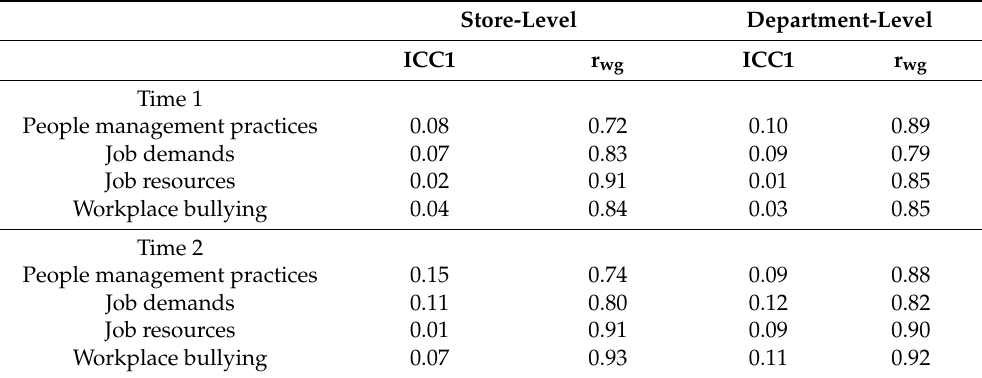
Table 2. Interrater reliability and intraclass correlation coefficient